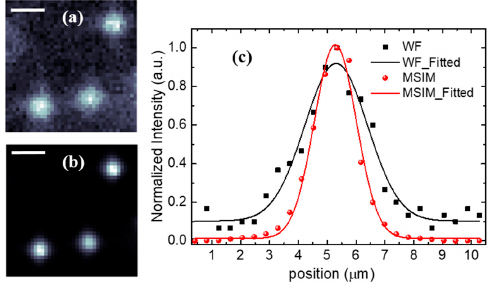
Figure 5. Image results of three separate microspheres by wide-field (WF) microscopy ( a ) and MSIM ( b ). ( c ) Cross-section through one of the microsphere images in ( a , b ), respectively. Scale bars: 4 μ m.